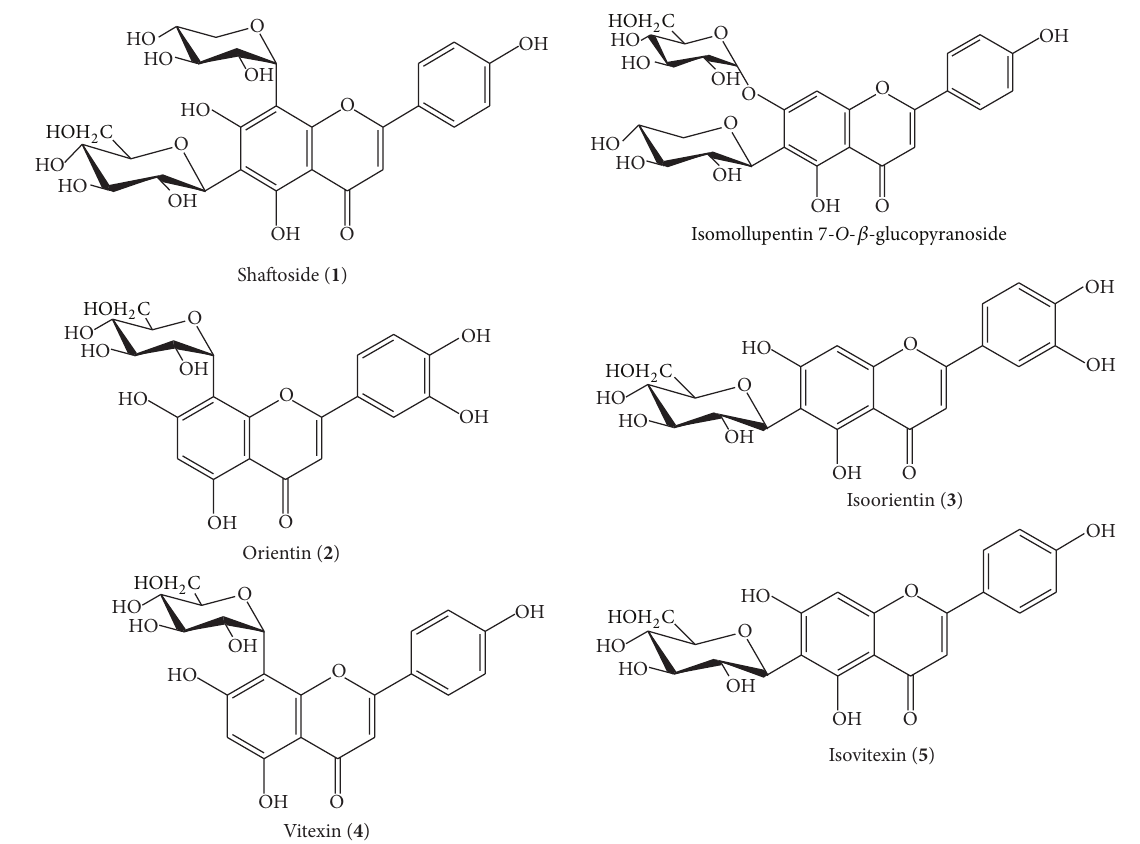
Figure 1: Chemical structures of known flavone C -glycosides shaftoside ( 1 ), isomollupentin 7- O - 𝛽 -glucopyranoside, orientin ( 2 ), isoorientin ( 3 ), vitexin ( 4 ), and isovitexin ( 5